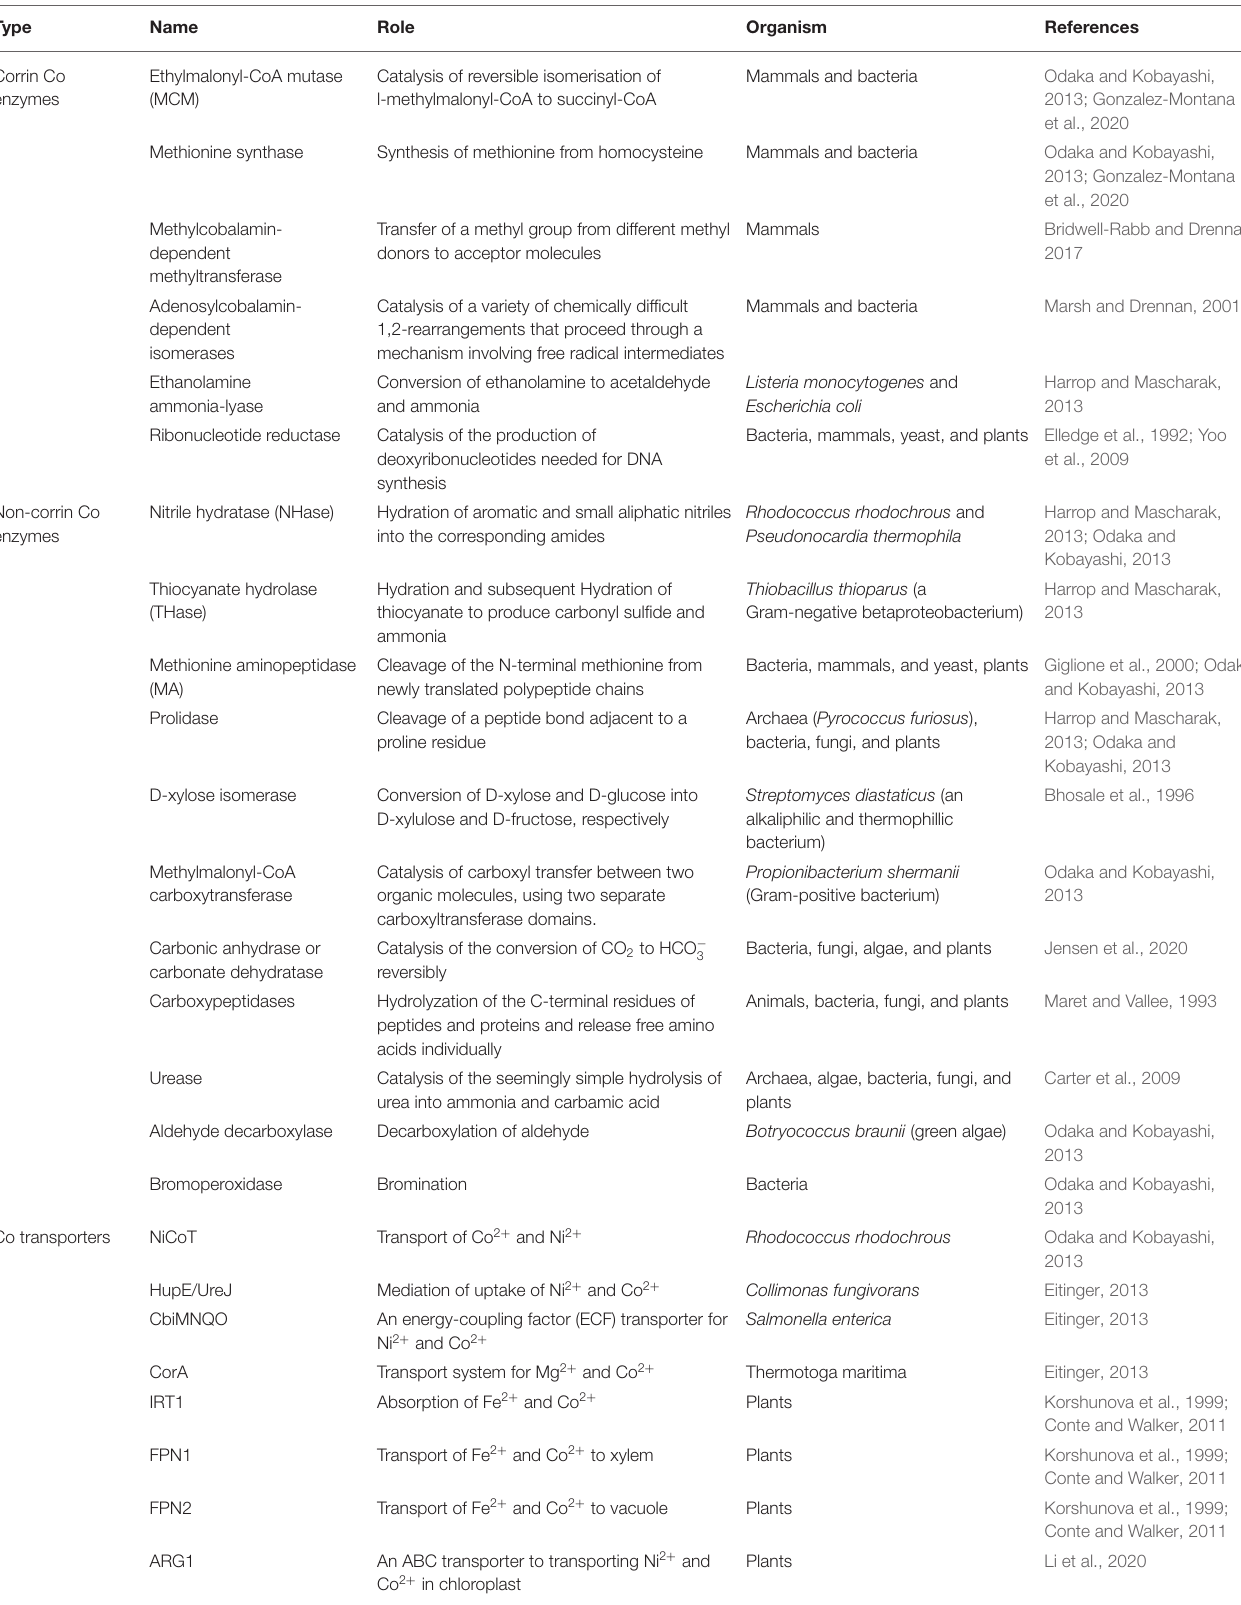
TABLE 1 | Cobalt-containing enzymes, proteins, and transporter relevant or potentially relevant to plant